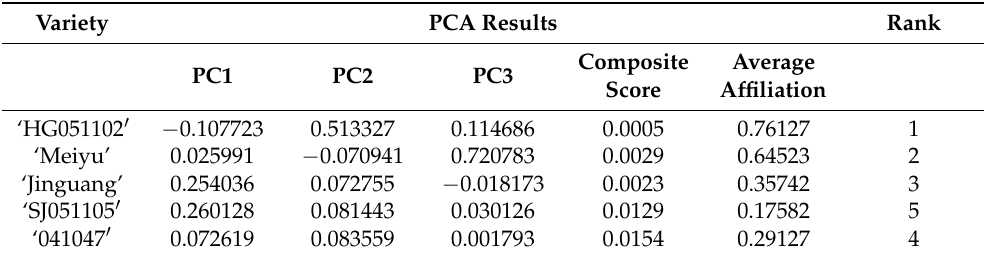
range of low temperatures.